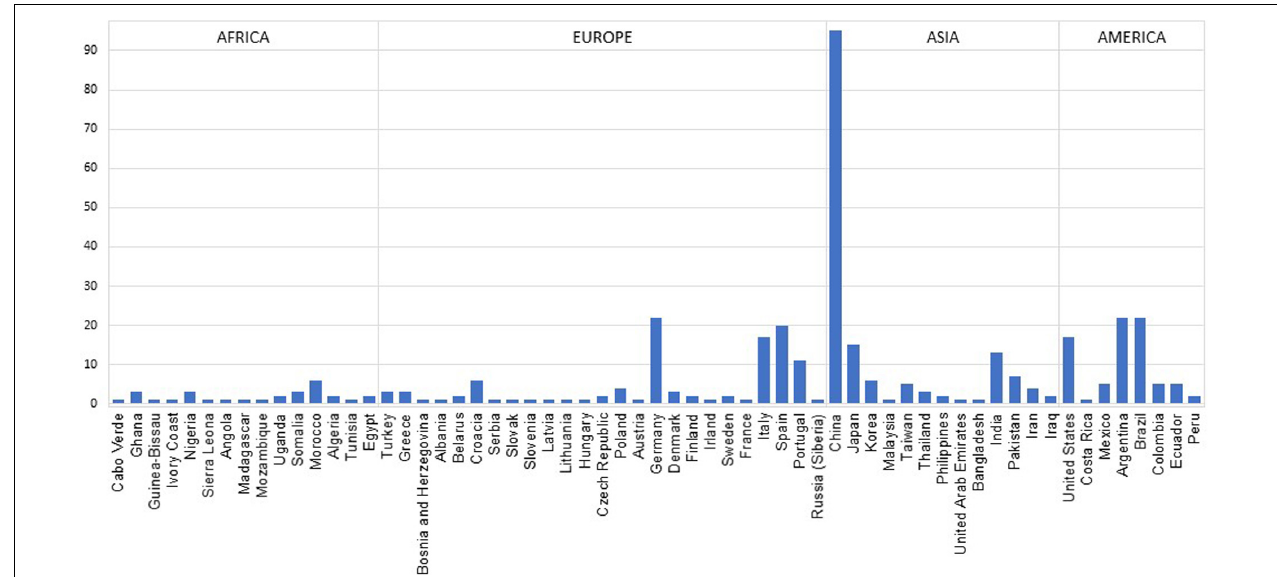
FIGURE 3 | Compilation of number of datasets per country. Data were obtained from publications referenced in Supplementary Table 2